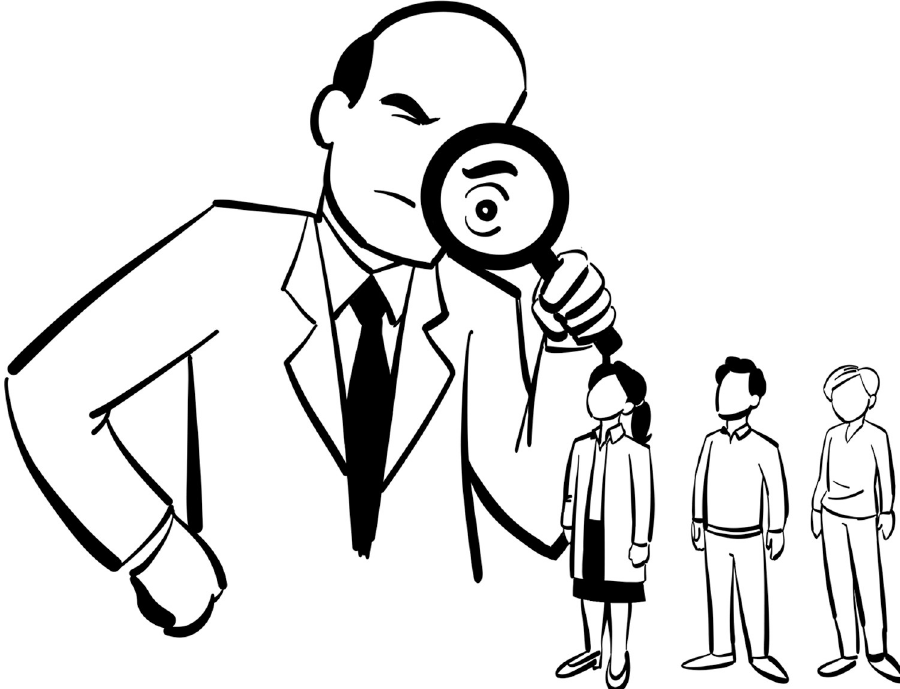
Fig 8. Micromanagers can have a soul-crushing